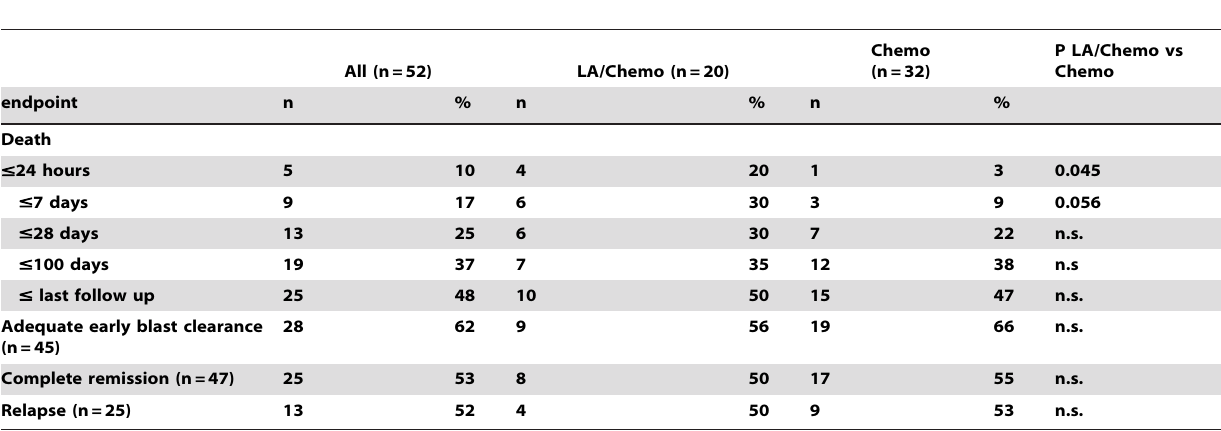
Table 4. Outcome in all patients, patients with therapeutic leukapheresis plus chemotherapy and patients with chemotherapy only.